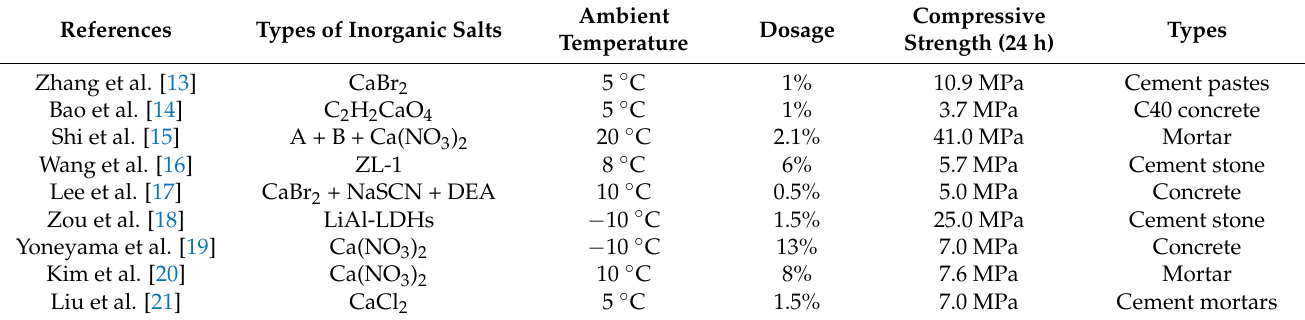
Table 1. Summary of the related effects of inorganic salt early-strength agents in the literature.